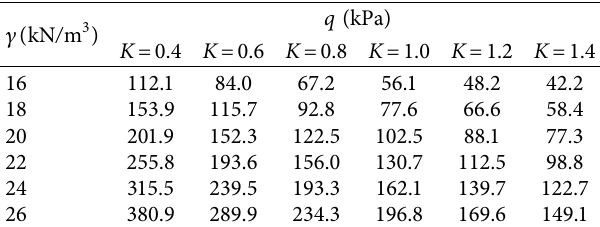
T ABLE 1: Upper bound solution of the surrounding rock pressure q at different c and K .